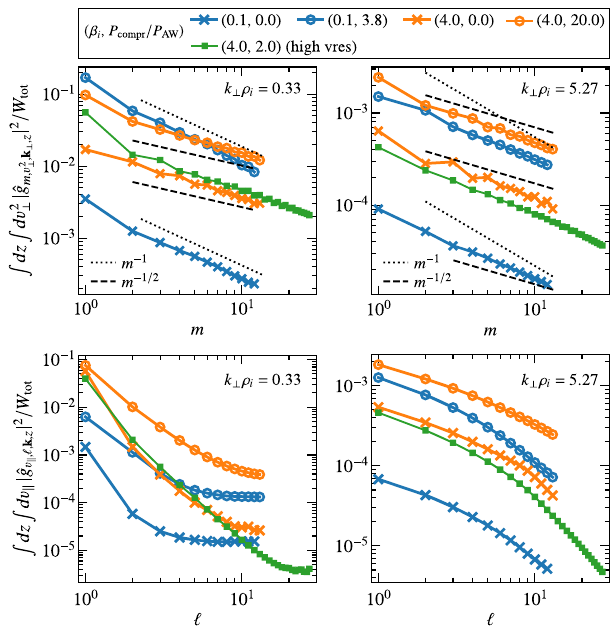
FIG. 4. Hermite (top) and Laguerre (bottom) spectra of the gyroaveraged perturbed ion distribution function g (normalized i 0 . 33 (left) and at k ρ 5 . 27 by the total energy) at k ⊥ ρ ⊥ i ¼ i ¼ 0 . 1 and (right). The blue and orange lines correspond to β i ¼ β 4 , respectively. The crosses (circles) correspond to the cases i ¼ without (with) compressive driving. m and l stand for the Hermite and Laguerre moments, respectively. The spectra are integrated over z and v ⊥ for the Hermite spectrum and over z and v for the Laguerre spectrum. For the Hermite spectra, the k auxiliary lines m − 1 (suggesting suppressed Landau damping or phase mixing [35,72,75]) and m − 1 = 2 (suggesting strong Landau damping [72]) are shown for reference. The green squares correspond to the higher-velocity-space-resolution run, and they are consistent with the “ fiducial ” runs, suggesting numerical convergence with respect to the velocity